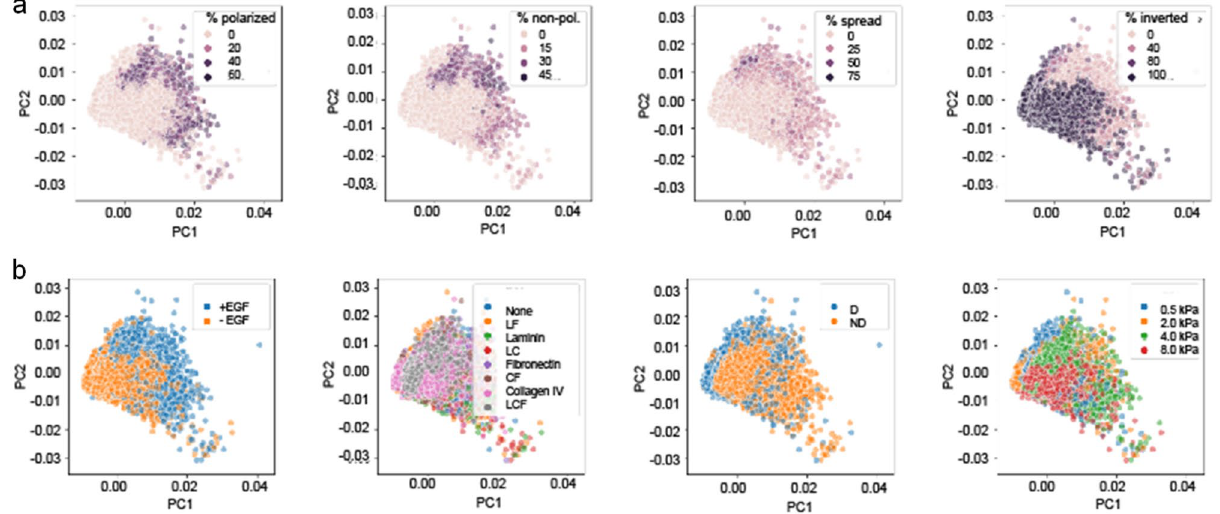
Figure 3. Feature mapping on principal components 1 and 2. Visualization of phenotype frequency ( a ) and microenvironmental factors on principal components 1 and 2 ( b